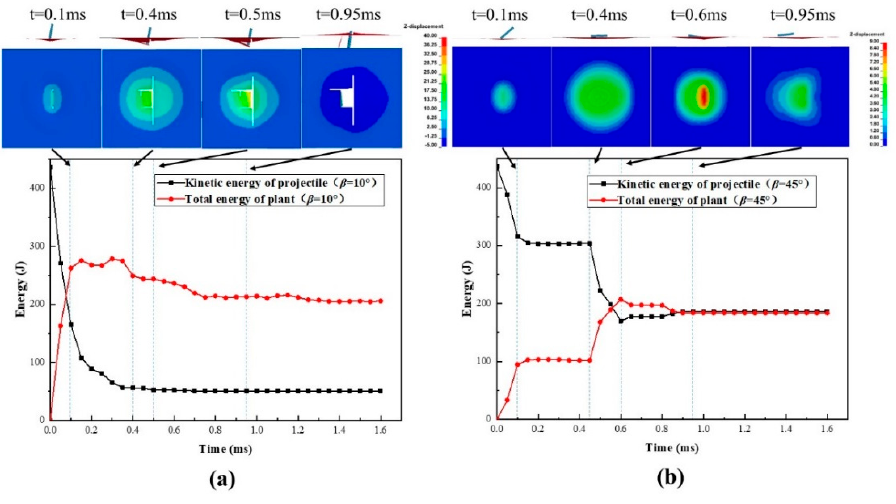
Figure 9. Energy evolution process and impact damage process for Laminate60 under impact V cr,n =125m/s with two different velocity deflection angles: ( a ) β = 10° and ( b ) β = 45°.